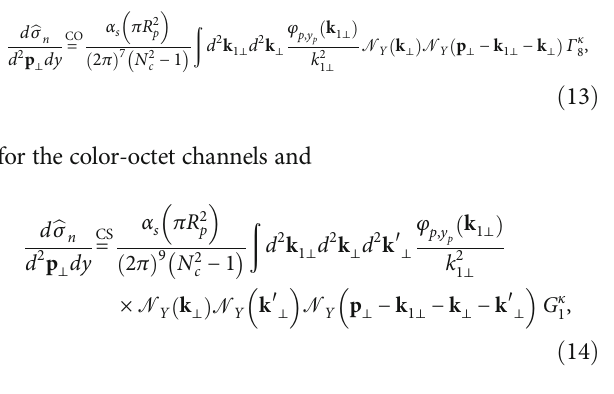
θ in the Collins-Soper frame as functions of p T . Data from [132